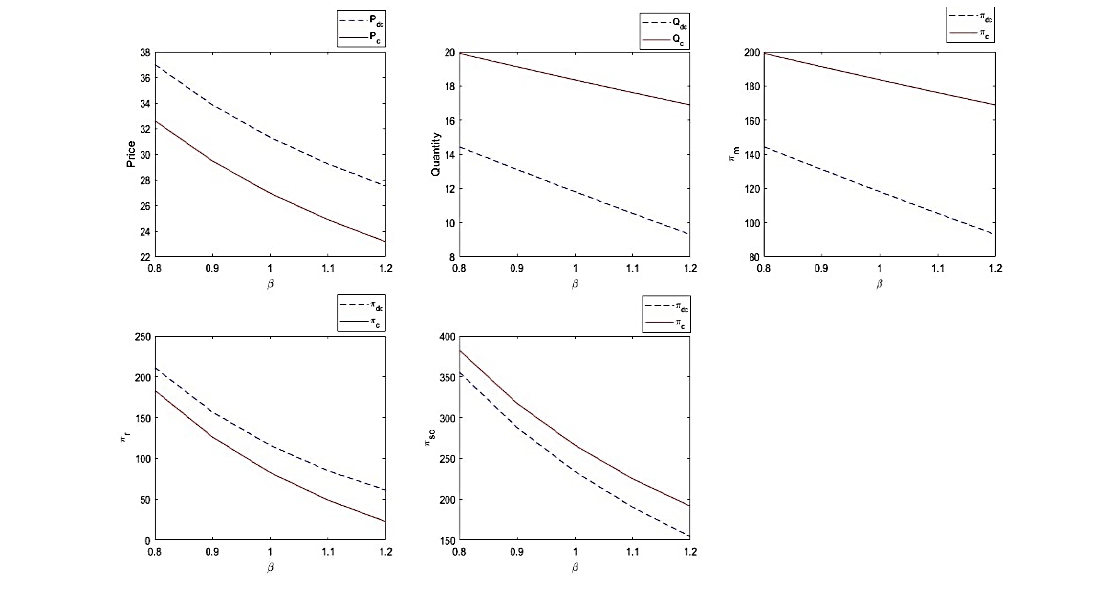
Fig. 5. The trend of variations in decision variables due to variations in parameter β .